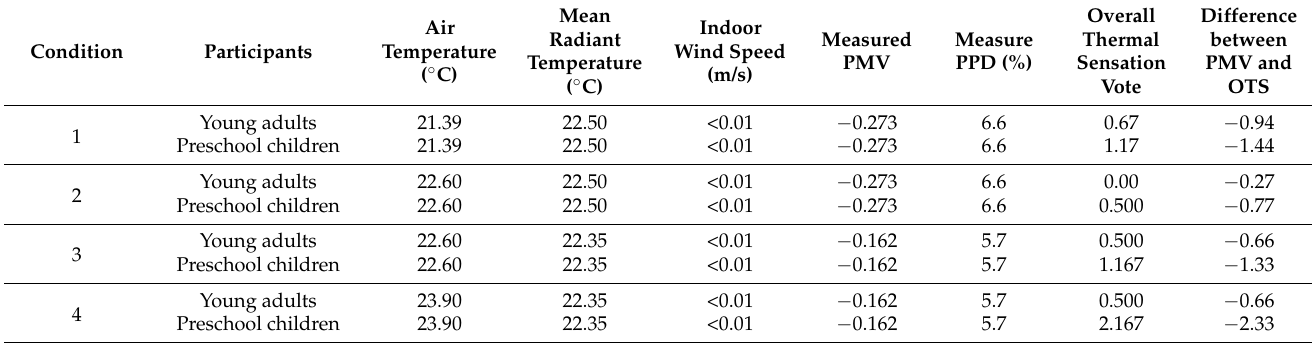
Table 9. Difference between measured PMV and overall thermal sensation